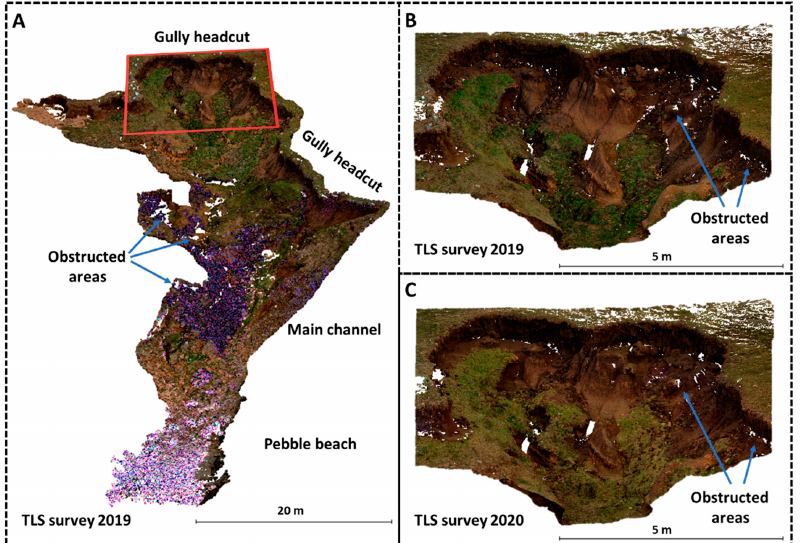
Figure 8. Point clouds created from carried out multi-temporal TLS surveys (( A )—point cloud of whole gully (SA-1) ( Parts of point cloud for SA-1 with purple texture were collected after the twilight, which caused errors in stored texture information ); ( B , C ) point clouds of chosen part of gully headcut (SA-2) used for detection and quantification of STCs). Both multi-temporal TLS surveys have confirmed the accuracy and excellent perfor- mance of the carried out optimization, with minimal deviations of the achieved TLS sur- vey coverage from the planned coverage in both SA-1 and SA-2. In total, the initial TLS survey covered 1181.07 m 2 of SA-1 (96.26% of the total study area), which deviates from planned coverage for only 8.97 m 2 , or 0.73% (Table 2). The highest concentration of obstructed areas was in the middle part of the gully, within the deeply incised sub-channels of the main gully channel (Figure 9B). Table 2. Difference in total planned and achieved coverage for TLS survey 2019 over whole gully (SA-1).